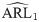

ARL^1 curves evaluation for the inflated beta regression control chart (solid line), regression control chart (dashed line), and inflated beta control chart (dotted line) when the precision is out-of-control.